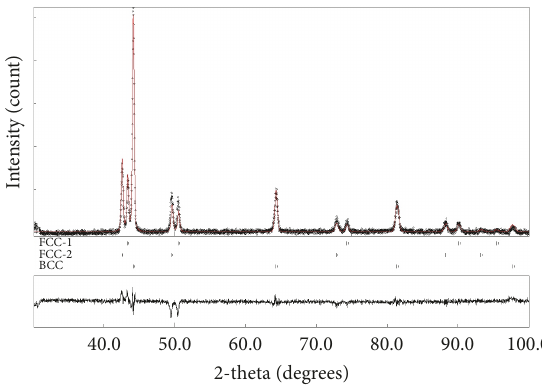
Figure 2: Rietveld refined X-ray diffractogram of heat-treated